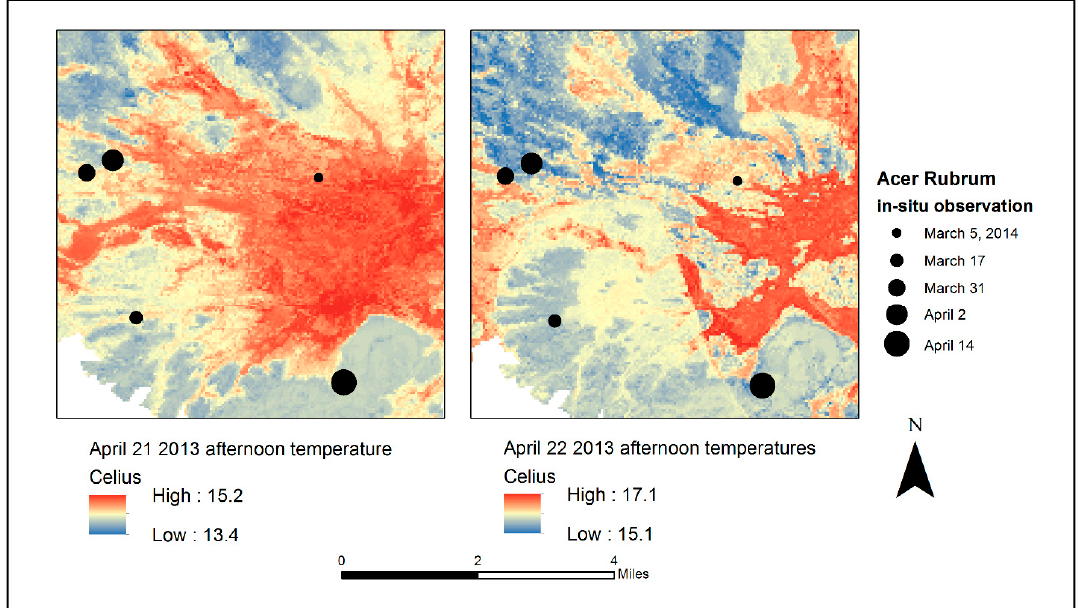
Figure 10. Patterns for estimated April 2013 temperatures and A. rubrum in-situ leaf bud burst observations for 2014. Earlier bud burst occurs in areas where temperatures are higher.